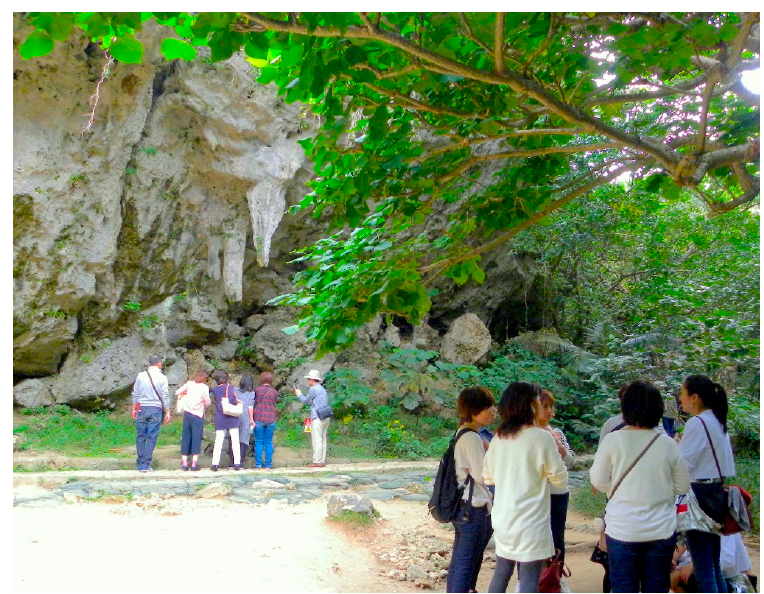
Figure 3. Powerspot tourists standing in a circle in front of the sang ū i rock, feeling the sacred energy of S ē fa Utaki.